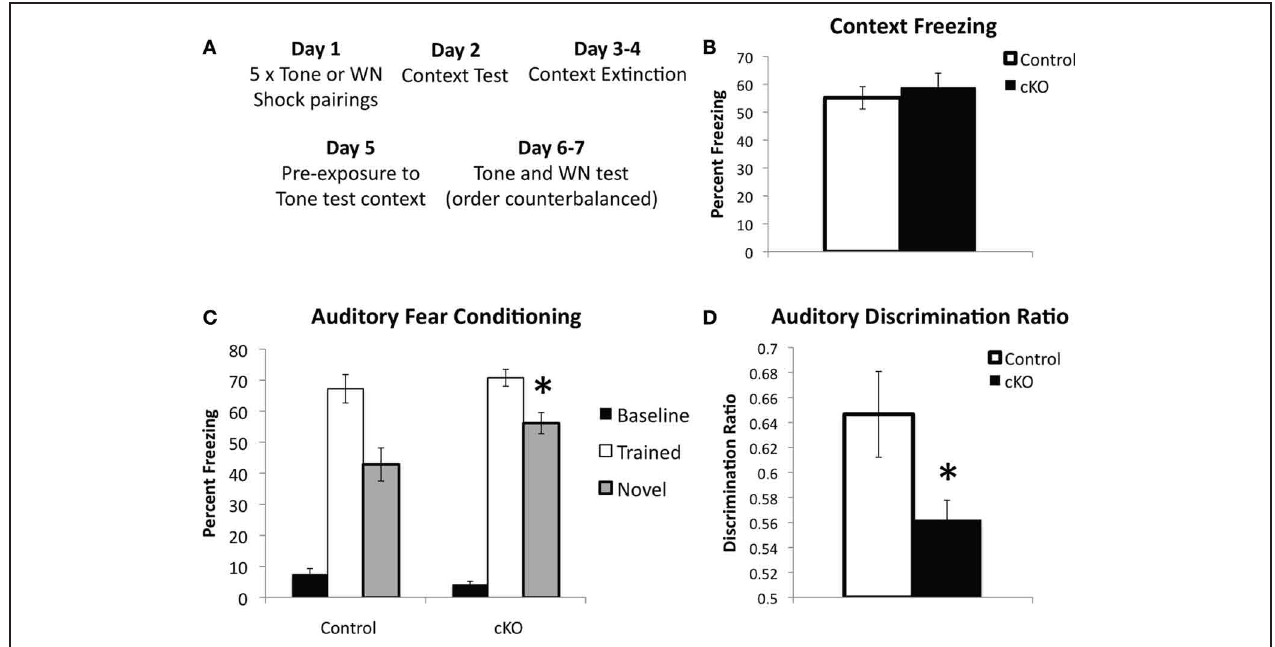
FIGURE 5 | DNMT1-cKO mice show normal hippocampus-independent auditory fear conditioning but enhanced generalization to a novel auditory stimulus. (A) Experimental design: mice received five white noise or tone-shock pairings on Day 1; followed by a Context Test on Day 2; two days of context extinction on Days 3–4, pre-exposure to the tone test context on Day 5; two days of testing for auditory fear on Days 5–6, where both